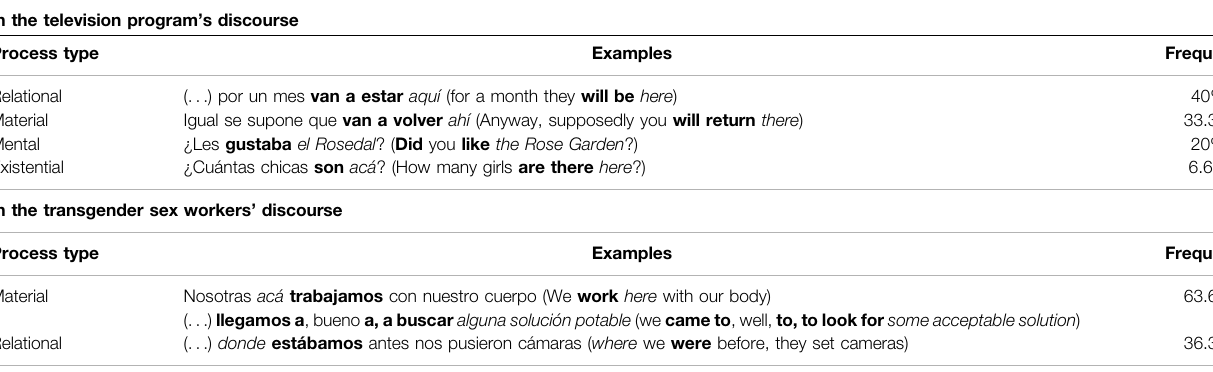
TABLE 8 | The transgender sex workers ’ actions and states (in bold) related to the Space category (in italics). In the television program ’ s